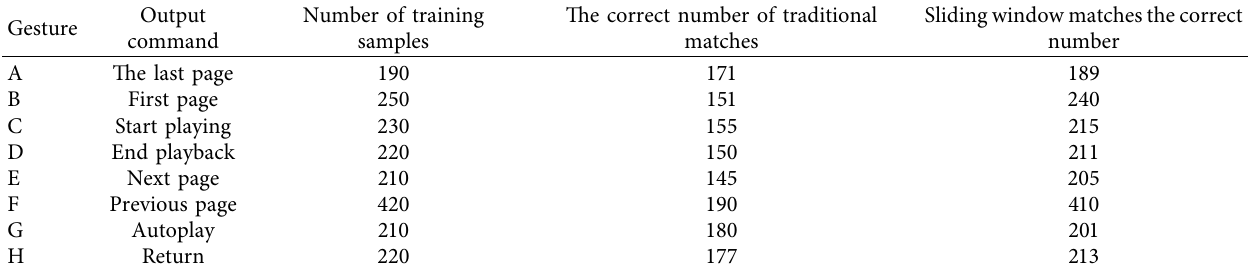
Table 6: Comparison between the original method and the proposed sliding window method.